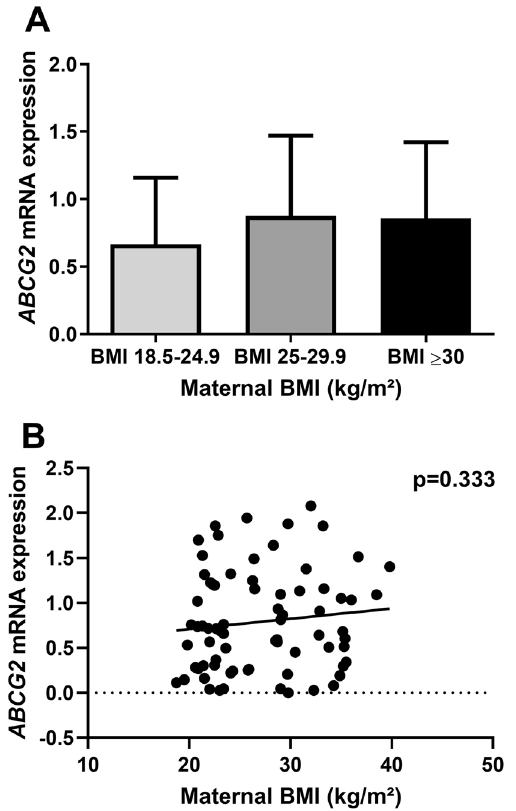
Figure 4. ABCG2 mRNA expression and maternal BMI in placental tissue. ( A ) ABCG2 mRNA expression in the three maternal BMI groups; normal weight (BMI: 18.5–24.9 kg/m 2 (n = 34)), overweight (BMI: 25–29.9 kg/ m 2 (n = 18)), and obese (BMI ≥ 30 kg/m 2 (n = 22)). No statistically significant difference was found (one-way ANOVA, F(2,71) = 1.255, p = 0.291). A p value < 0.05 was considered statistically significant. Each bar represents mean ± SD. ( B ) Expression of ABCG2 evaluated by using linear regression. Each dot represents one sample (n = 74), and line represents best fitted line. Slope = 0.011, F(1,72) = 0.949, R 2 = 0.013, p = 0.333. A p value < 0.05 was considered statistically significant. One sample was removed due to technical